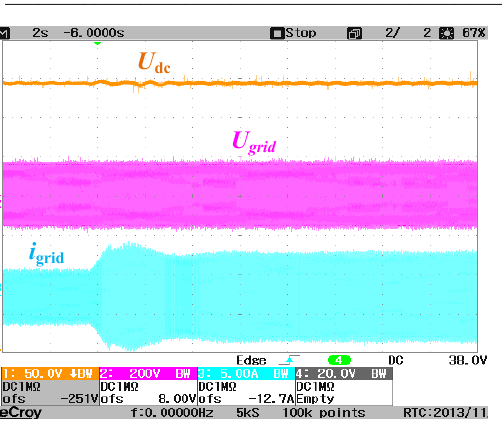
Fig. 20. Response for step change of speed with APFF. From top: dc-link voltage ( U dc ), grid voltage ( U grid ), grid current ( i grid